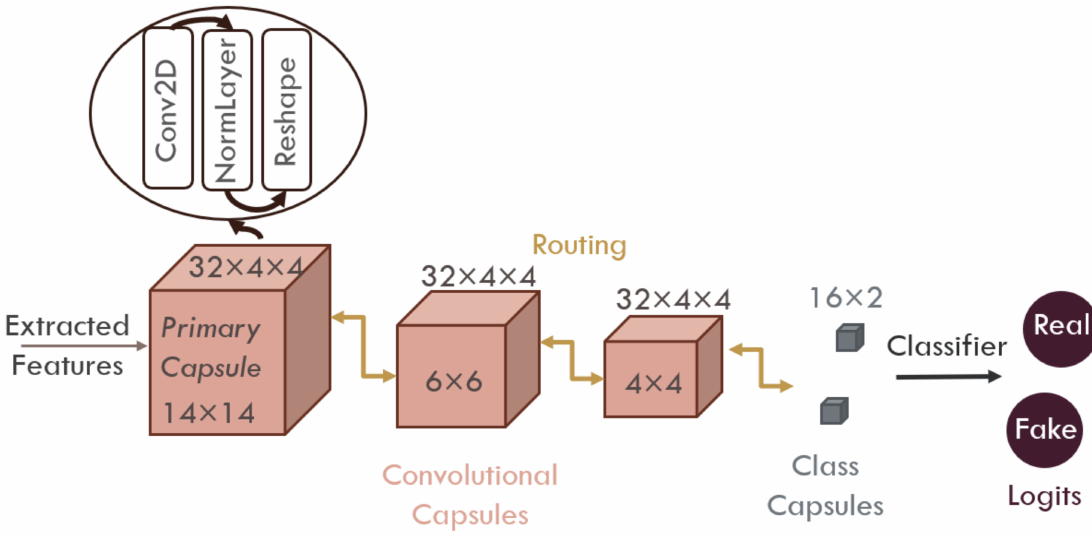
Figure 8. Capsule Network